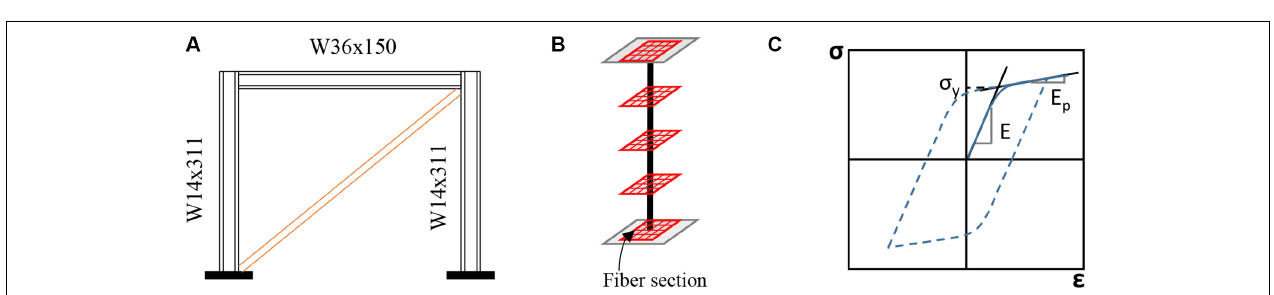
FIGURE 7 | (A) Pure analytical model of the CBF, (B) distributed plasticity with fiber sections for non-linear elements, (C) steel 02 model stress–strain relationship.